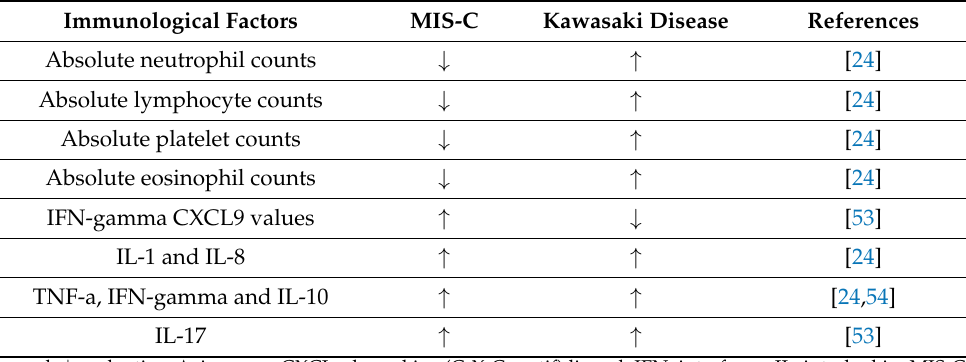
Table 2. Innate immunological differences encountered in MIS-C compared to Kawasaki disease. Immunological